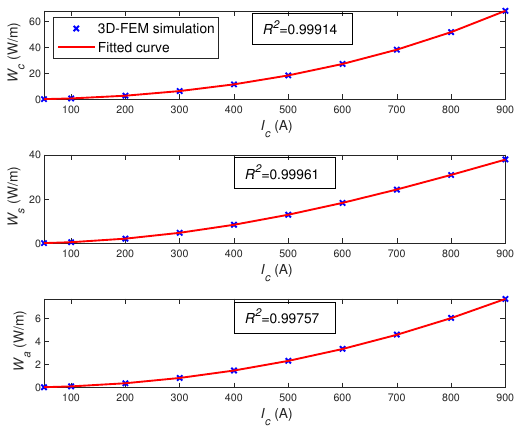
Figure 12. Estimated and simulated heat losses for test ambient temperature θ amb = 10 ◦